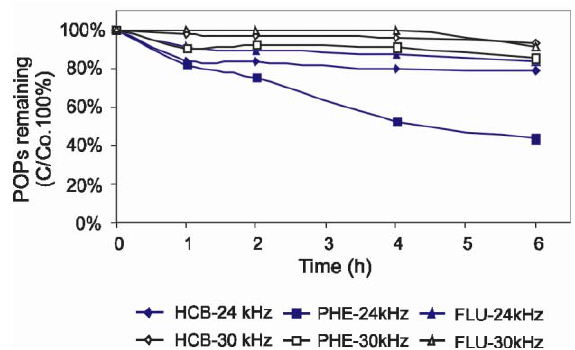
Fig. 5. HCB and PHE residuous concentrations in kaolin with increasing intermittent ultrasound irradiation